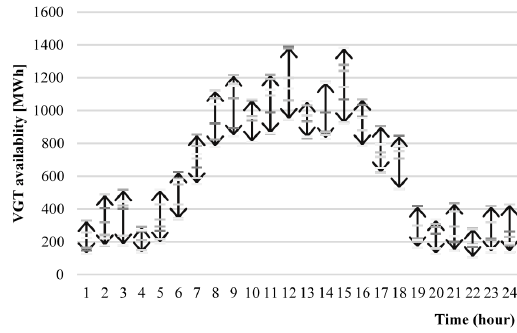
Figure 2. Scenarios of variable generation technologies (VGT).